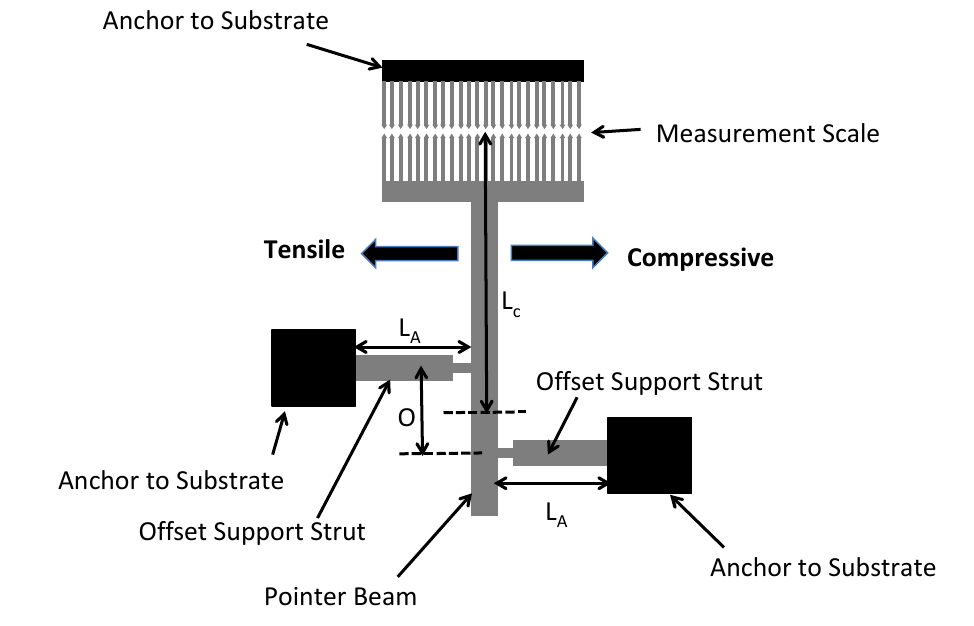
Figure 12. Pointer beam test structure.